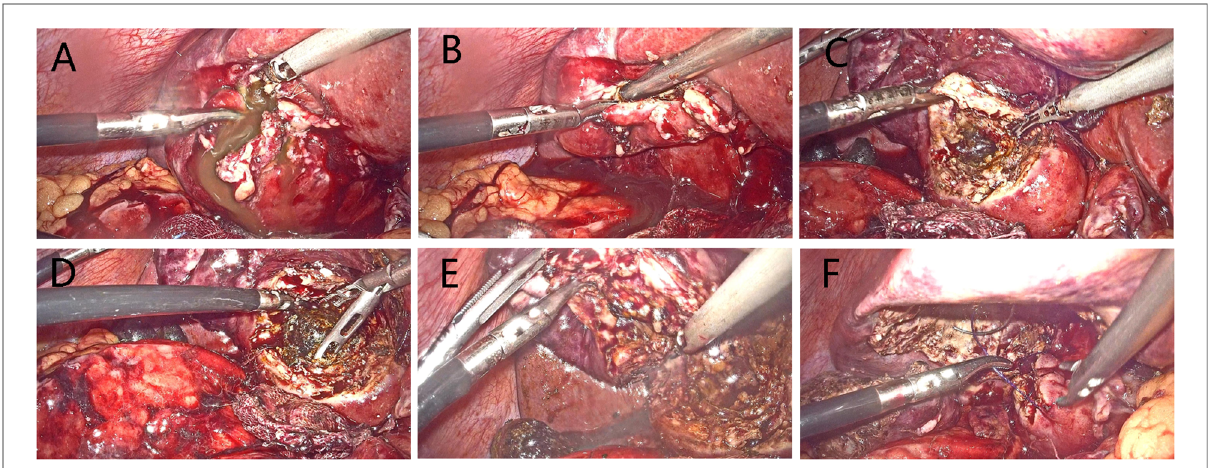
FIGURE 3 Procedures of laparoscopic subtotal cholecystectomy. ( A ) Making an incision in the gallbladder fundus. ( B ) Aspirating the contents to decompress gallbladder. ( C ) Opening of Hartmann ’ s pouch. ( D ) Clearing the stones obstructing the gallbladder outlet. ( E ) Removing as much of the gallbladder wall as possible. ( F ) Suture of gallbladder